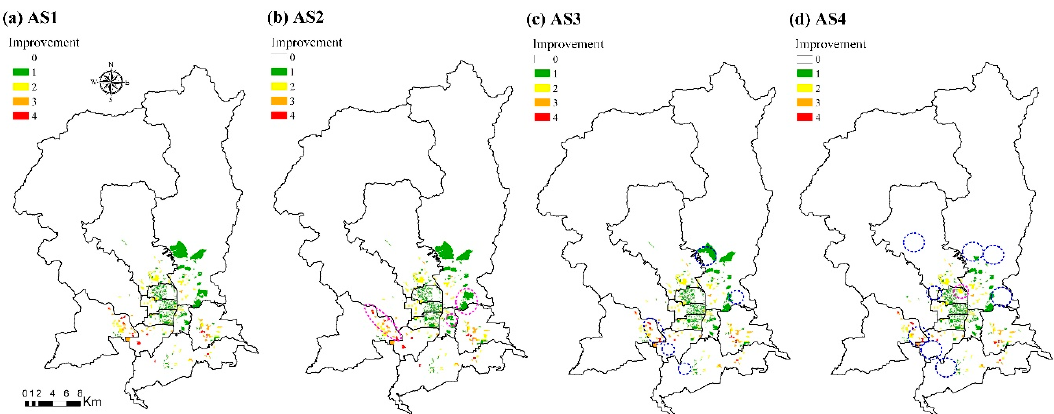
Figure 10. Decreased levels of climate risk in each section of village with the potential climate adaptation strategies for 2015. Note: The numbers of improvement, 4, 3, 2, and 1, indicate that the risk levels decrease from 5 to 4, from 4 to 3, from 3 to 2, and from 2 to 1, respectively. The number 0 means that the risk level does not change. The blue dotted circles for AS2, AS3 and AS4 indicate that the improvement decreases compared to AS1; the pink dotted circles for AS2, AS3 and AS4 indicate that the improvement increases compared to AS1.